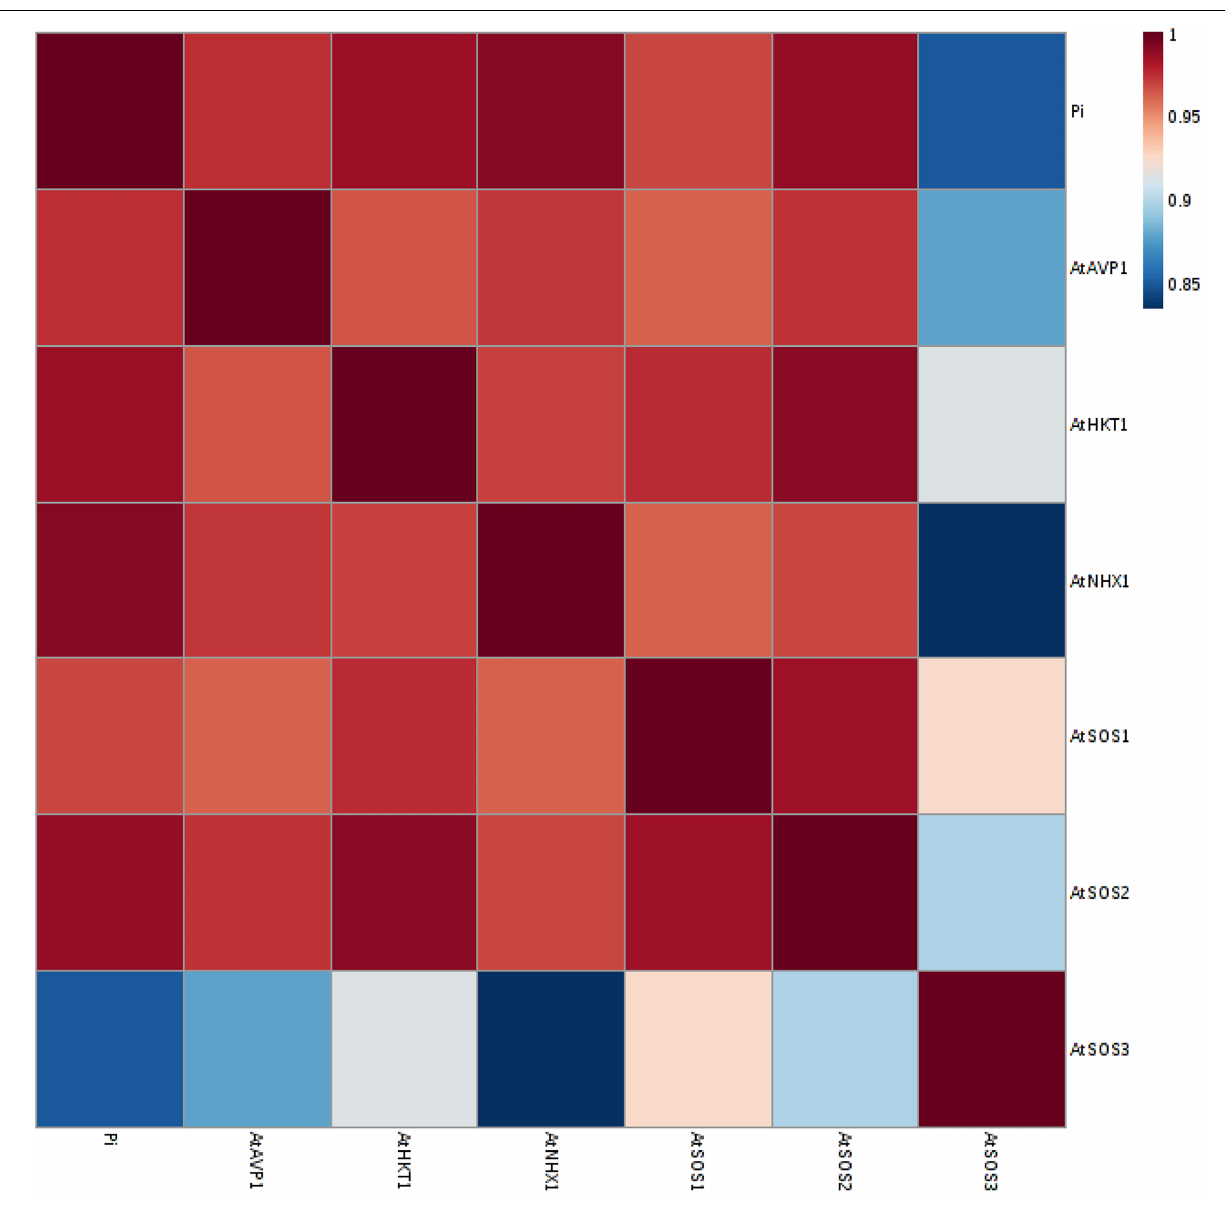
FIGURE 8 | A Heat-map of correlations between the expression level of AtSOS1 , AtSOS2 , AtSOS3 , AtHKT1 , AtVPV1 , and AtNHX1 genes, and inorganic (Pi) content at 150 mM NaCl stress. The color key represents the quantile-normalized log10-transformed values. Dark red indicates high level whereas dark blue indicates low